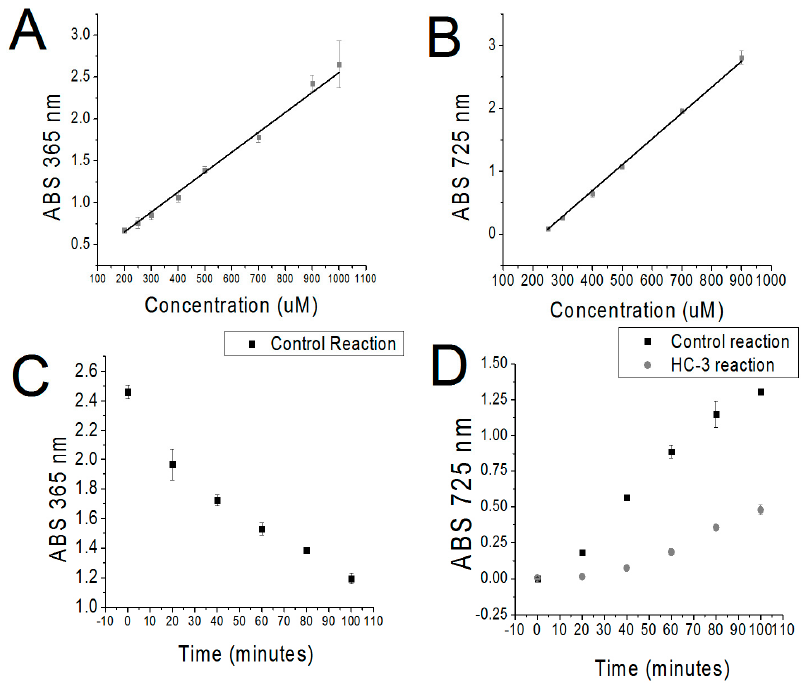
Figure 2. Standard concentration vs absorbance curves of Cho and PCho and colorimetric absorbance at different time points in an sChok enzymatic assay. ( A ) Standard curve of [Cho] vs absorbance derived from known quantities of Cho. ( B ) Standard curve of [PCho] vs. absorbance derived from known quantities of PCho. ( C ) Absorbance changes over time derived triiodide analysis of an sChok enzymatic assay (Control Reaction). ( D ) Absorbance changes over time derived from MBD analysis of an sChok enzymatic assay with (HC-3 reaction) and without (Control Reaction) sChok inhibitor